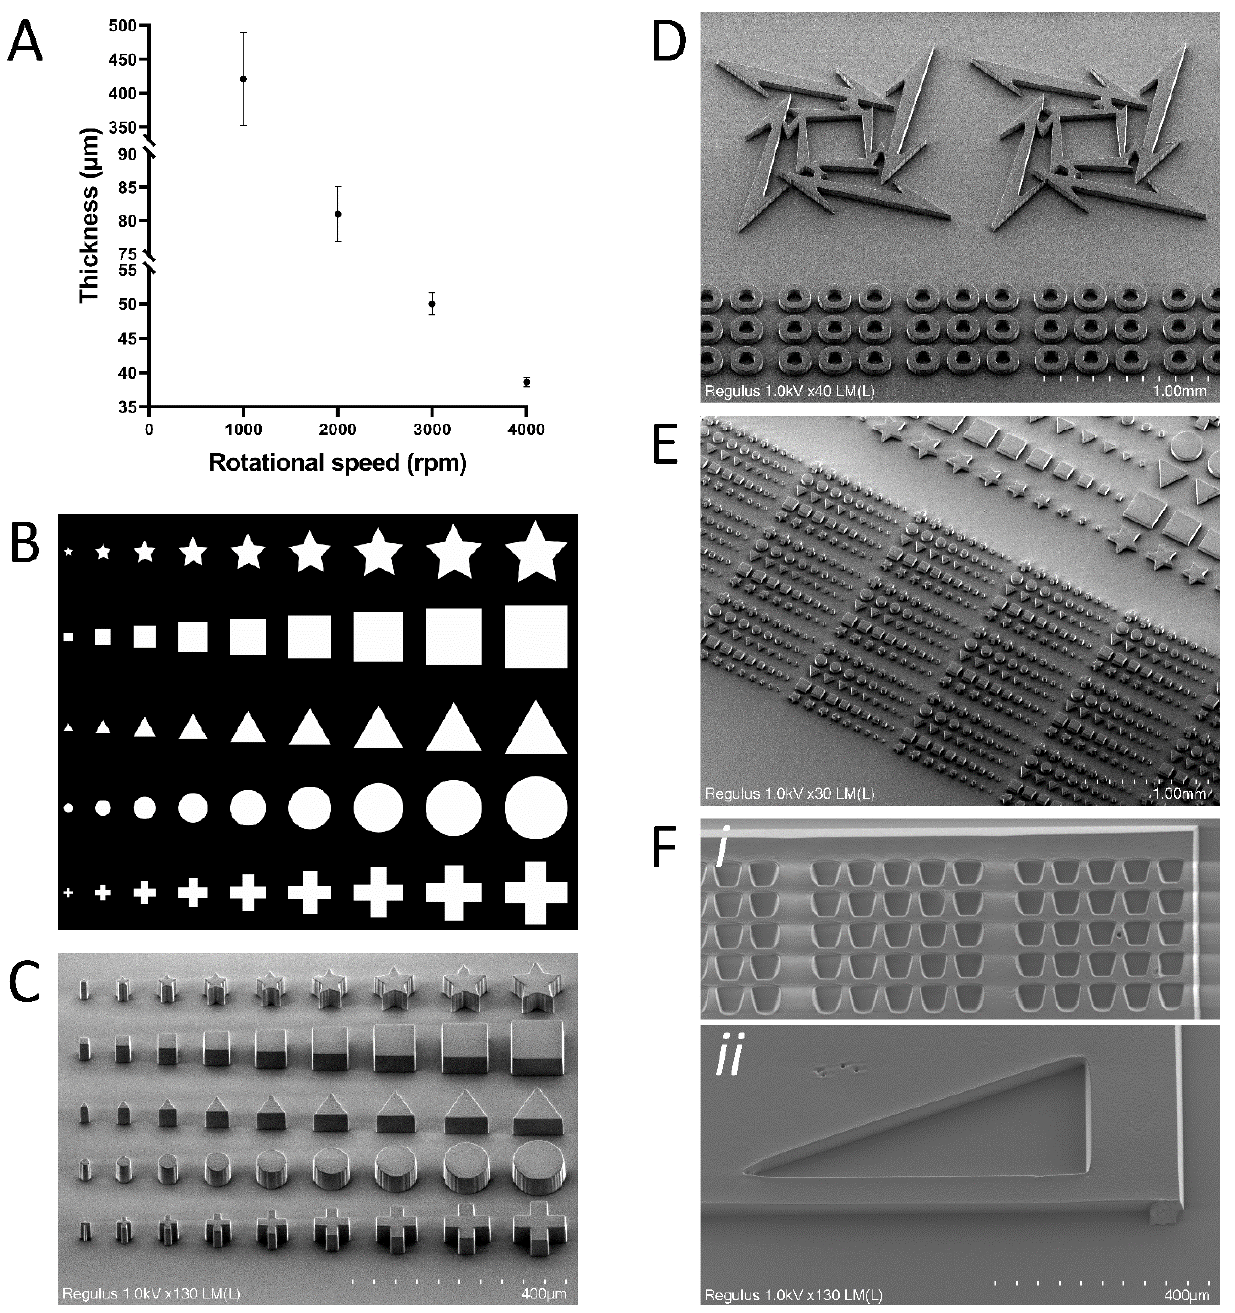
Figure 2. SU-8 microstructures generated using maskless photolithography on glass substrates. ( A ) Graph of obtained SU-8 layer thickness against the used spin coating speed. ( B ) Digital photomask design that was used for backside UV exposure using the PRIMO system and a 5X objective. ( C ) SEM images of 50 µm tall structures of various geometries that were microfabricated with high accuracy, as evident by the sharp edges and high reproducibility. ( D ) SEM image of more complex structures. These large structures were generated by the auto-stitching feature of the system, enabling the generation of large and continuous structures. ( E ) SEM image showing that whole arrays of microstructures can be microfabricated in large areas on the substrates. ( F ) SEM image of properly developed SU-8 that was exposed to inverted patterns. (i) SU-8 structures to generate pillars for hydrogel patterning. (ii) Acute angles are properly